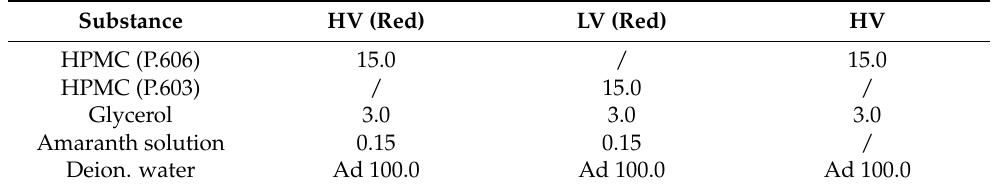
Table 1. Placebo solutions for the evaluation of the subdivision models (% w / w , HV: higher